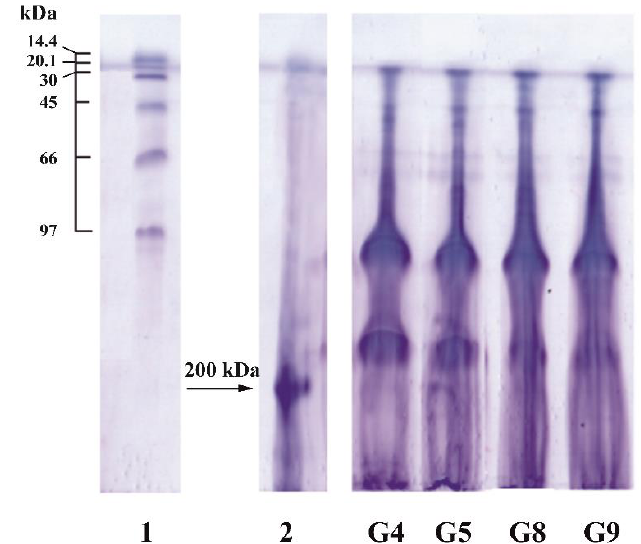
Figure 3. Electropherogram of gelatin samples obtained from cod skin at different pH. Electropherograms of standard low molecular weight markers (GE Healthcare) (1) and a reference sample with M w = 200 kDa (2) are shown.